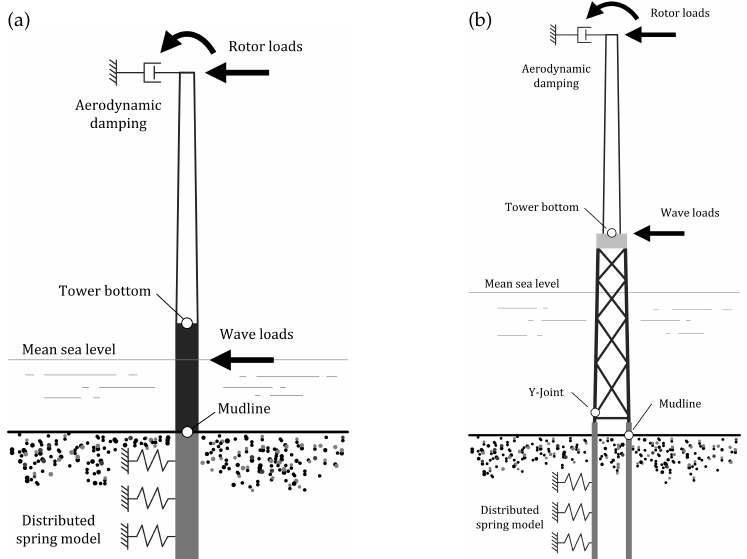
Figure 2. Illustration of numerical models used for example calculations. ( a ) OC3 monopile. ( b ) OC4 jacket with additional soil model. Output locations are